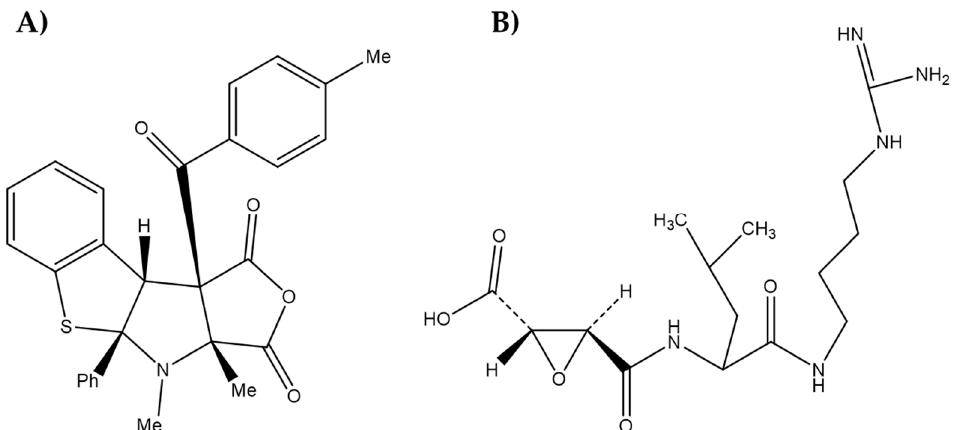
Figure 1. Structures of Leishmania CPB inhibitors: ( A ) (4aS,9bS,9cS)-4-methyl-9c-(4-methylbenzoyl)- 4a-phenyl-4,4a,9b,9c-tetrahydro-1H-benzo[4,5]thieno[2,3-b]furo[3,4-d]pyrrole-1,3(3aH)-dione and ( B ) L-t rans -epoxysuccinyl-leucylamido-(4-guanidino)butane (E64).